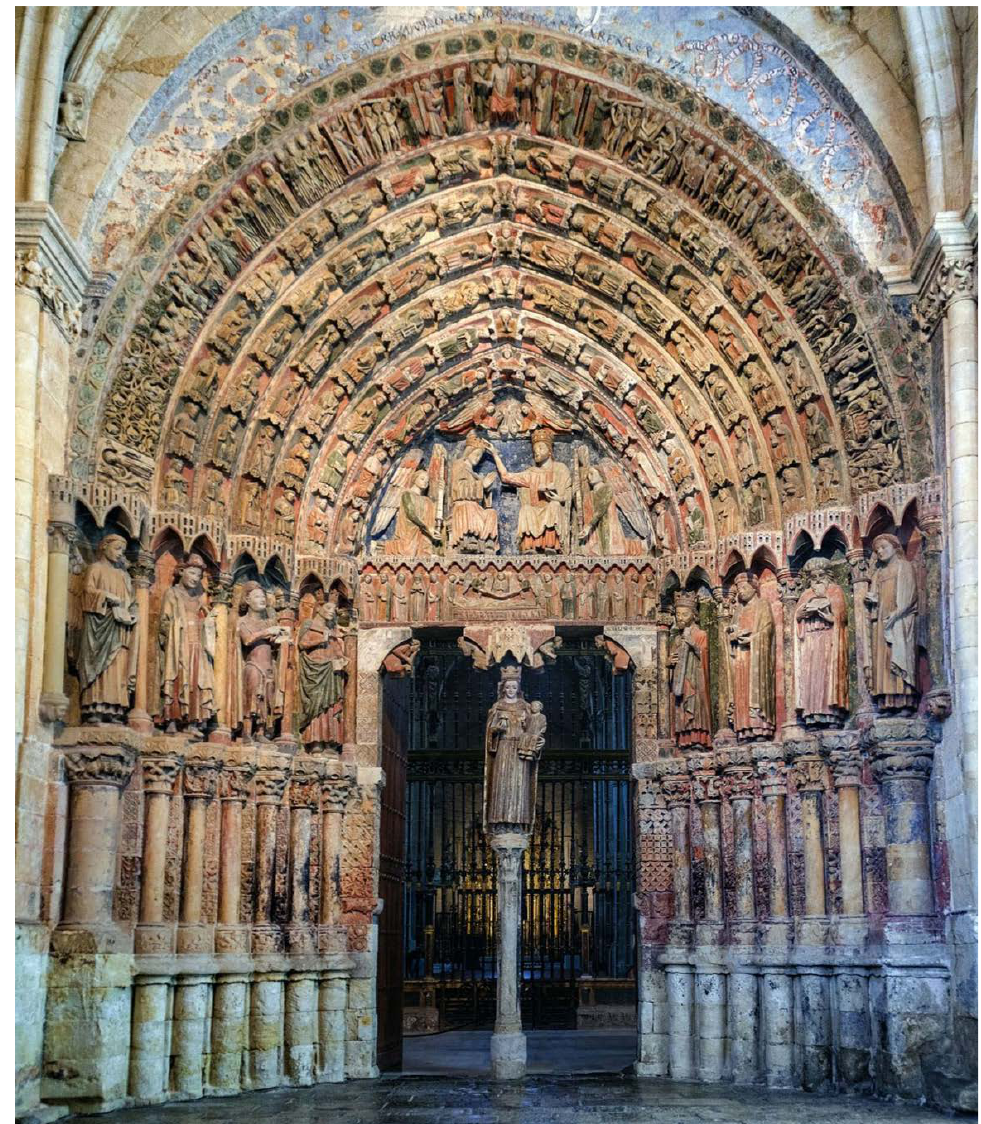
Figure 6. Portal of the Majesty , late 13th–early 14th century. Collegiate Church of Santa María la Mayor of Toro (Zamora).